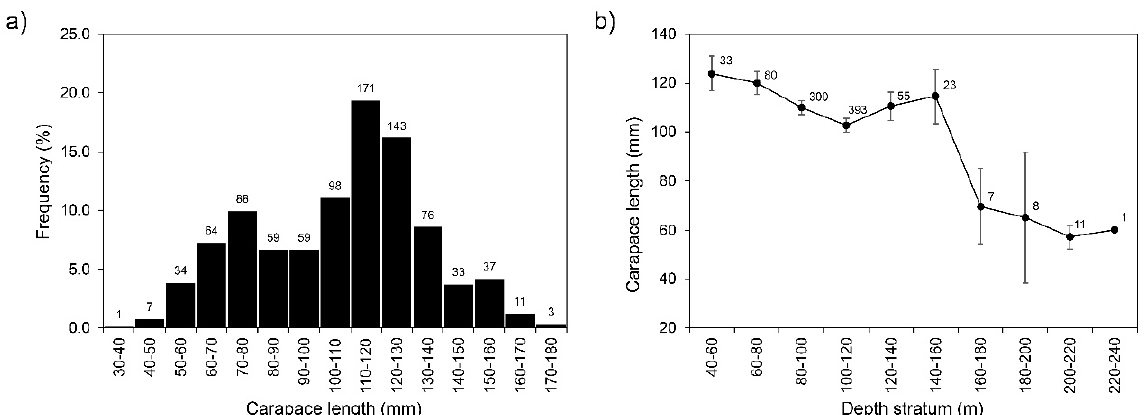
Figure 2. Length-frequency distribution ( a ); and mean ± 0.95 confidence interval carapace length (mm) by depth stratum ( b ) of Palinurus elephas from the Azores sampled during the 2000–01 period. Numbers inside the graph represent the number of individuals ( n ).